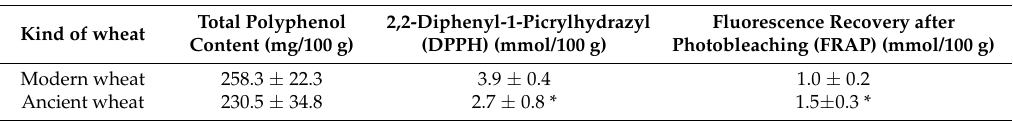
Table 2. Total polyphenol content and antioxidant activities of the tested ancient and modern wheats, expressed as mean ± standard deviation.